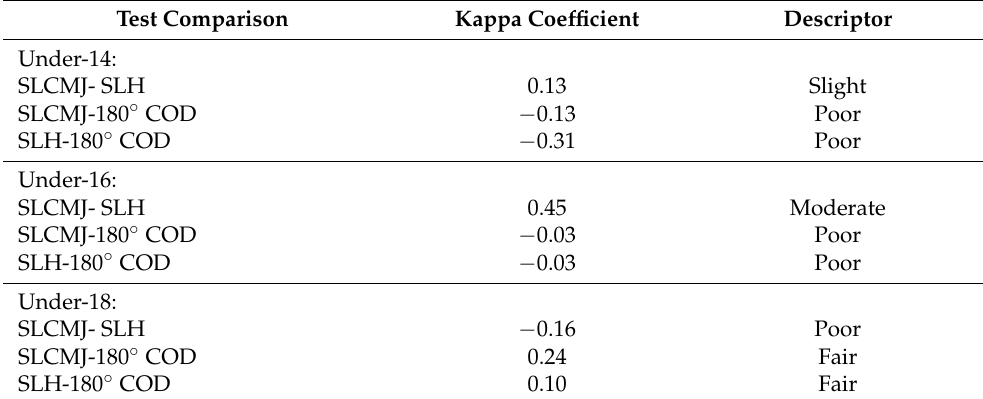
Table 3. Kappa coefficients and descriptive levels of concordance of asymmetries between the jumping speed and COD tests.